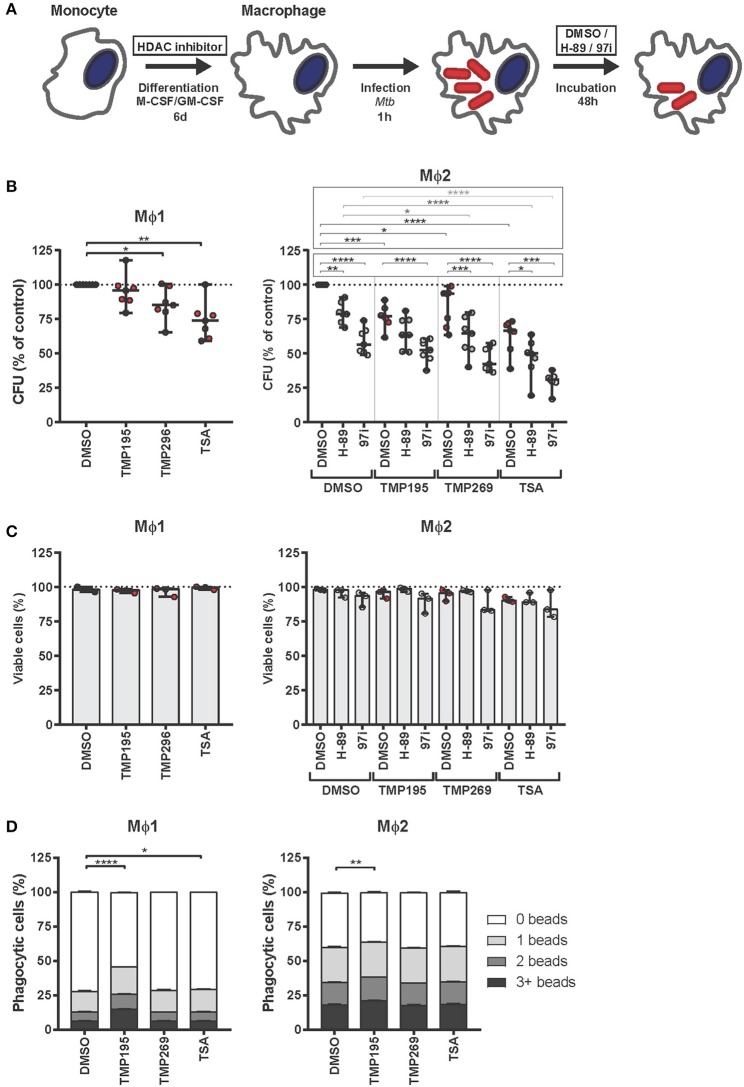
Macrophages exposed during differentiation to low concentrations of HDAC inhibitors are more bactericidal. (A) Outline of the experimental setup used in (B–D). (B) Monocytes derived from 7 different donors were differentiated toward Mϕ1 and Mϕ2 while being exposed to TMP195 (300 nM), TMP269 (300 nM), TSA (30 nM), or DMSO at equal v/v for 6 days. Differentiated Mϕ1 and Mϕ2 were subsequently infected with Mtb for 1 h at MOI 10 and incubated for 48 h post-infection until readout. Dots represent the mean of 3 CFU assay replicates of a single donor expressed as a percentage of the DMSO control. Horizontal lines indicate median CFU values of all 7 donors and whiskers represent 95% confidence intervals. Statistically significant differences compared to DMSO were tested using a RM one-way ANOVA (*p < 0.05; **p < 0.01; ***p < 0.001; ****p < 0.0001). (C) Cell viability measurement of Mtb-infected Mϕ1 and Mϕ2 (experimental setup as in B). Dots represent the mean of 3 cell viability assay replicates of a single donor expressed as a percentage of the DMSO control. Bars indicate median values of all 3 donors and whiskers represent 95% confidence intervals. Statistically significant differences compared to DMSO were tested using a RM one-way ANOVA. (D) Phagocytic capacity of Mϕ1 and Mϕ2 was evaluated by flow-cytometry using fluorescent beads (experimental setup as in B). Macrophages were categorized into populations containing either 0, 1, 2, or 3+ beads. Bars depict mean ± standard deviation of 3 replicates. Data shown is 1 representative donor out of 4. Statistically significant differences compared to DMSO were tested using a one-way ANOVA with Dunnett's multiple test correction (*p < 0.05; **p < 0.01; ****p < 0.0001).